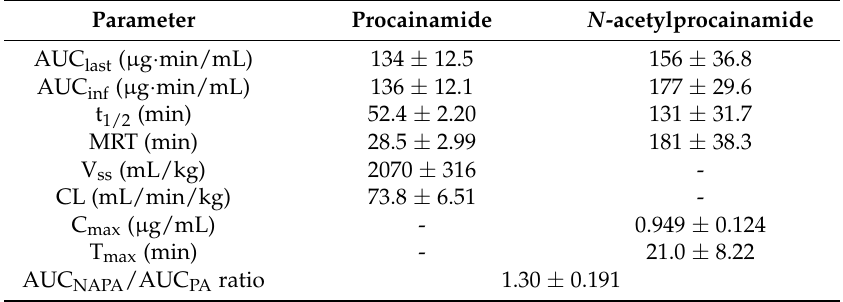
Table S1: Summary of HPLC bioanalytical method for simultaneous determination of procainamide and N -acetylprocainamide in the previous